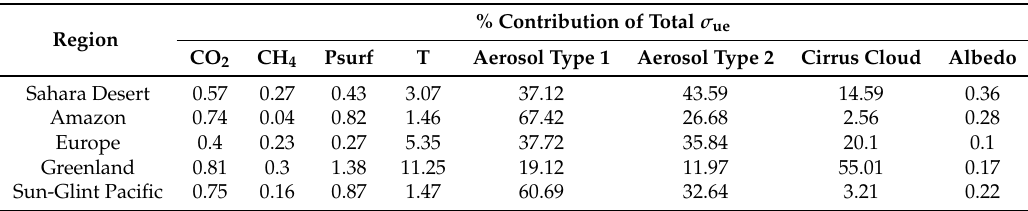
Table 3. Decomposition of the interference error σ i in to the individual contributions from the non-target state vector elements for the five sample regions. Values are presented as percentages of σ i